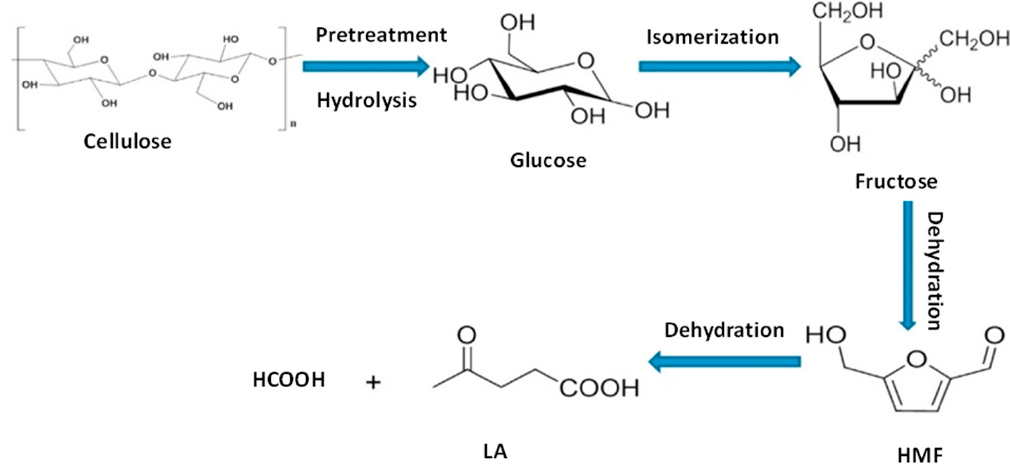
Figure 9. Conversion of cellulose into levulinic acid (LA). Reproduced with permission from ref. [108]